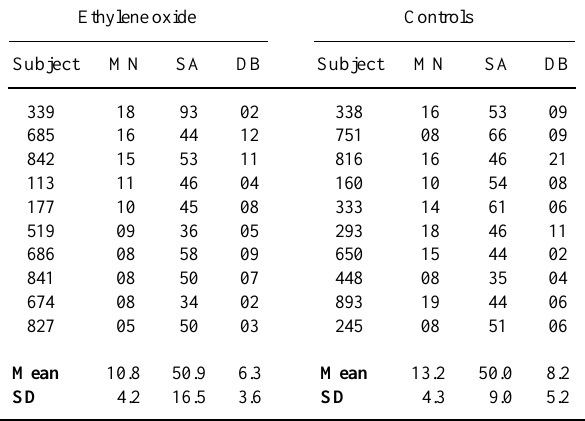
Table IV - Frequency of binucleated cells with micronuclei (MN) and other nuclear anomalies in 2000 cells analyzed per hospital worker potentially exposed to lead, and their respective controls.